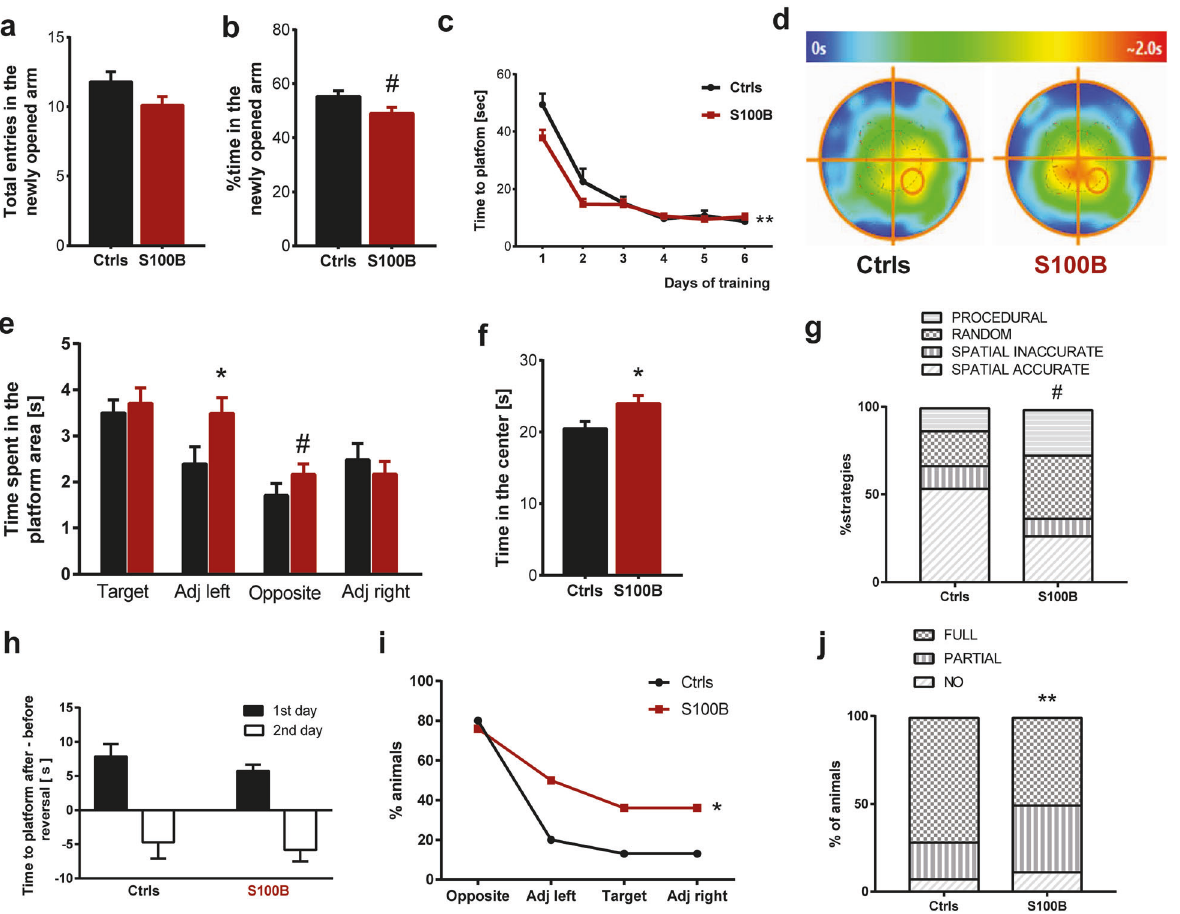
Fig. 7 Adult mice that received S100B injection during late embryogenesis show cognitive de fi cits. a No signi fi cant difference was observed in the entries into the newly opened arm between S100B and Ctrl mice ( p = 0.148) while ( b ) a trend for a signi fi cant decrease in time spent in the newly opened arm was observed in S100B mice ( p = 0.092). c Analysis of the learning curve showed a signi fi cant effect of S100B exposure (repeated-measures ANOVA, Time F (5, 43) = 80.862, p < 0.001, Treatment F (1, 43) = 3.715, p = 0.061, Time × Treatment F (5, 43)